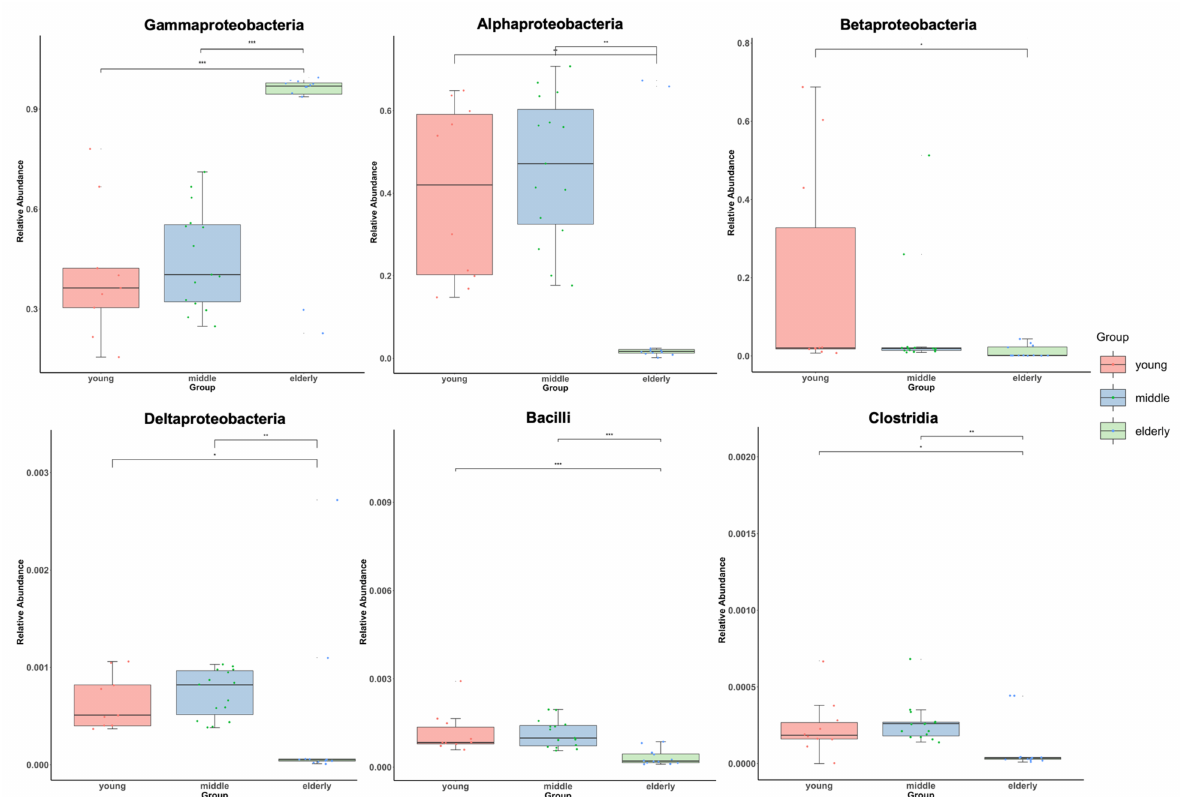
Figure 6. Boxplots showing a significant correlation between the three age groups and six classes compositions at the class level. The y -axis indicates relative abundances that were arcsine square root- transformed for taxon, with the analyses adjusted for sex and BMI. The x -axis indicates the three age groups; the young group had 10 individuals, the middle group had 15 individuals, and the elderly group had 12 individuals. The central line shown in each notched box plot indicates the median of the data. The detailed statistics are shown in Table S3. * q < 0.05, ** q < 0.01, and *** q <